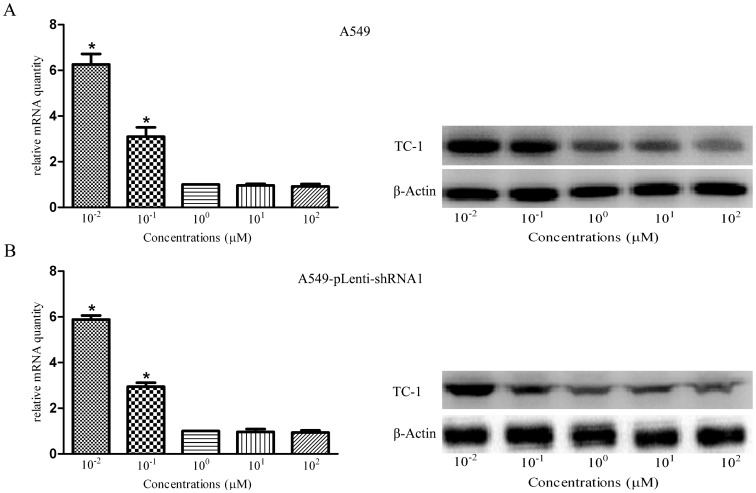
PD173074 inhibits the expression of TC-1 in A549 and A549-pLenti-shRNA1 cells.The qRT-PCR and western blotting results showed that the expression level of TC-1 decreased with an increase in the concentration of PD173074 and levels out when the concentration of PD173074 reaches 1 µΜ in A549 (A) and A549-pLenti-shRNA1 (B) cells. The columns represent the average of the relative mRNA quantity from at least three independent experiments. The bars show the SE. *indicates statistically significant changes (P<0.05) among five groups.